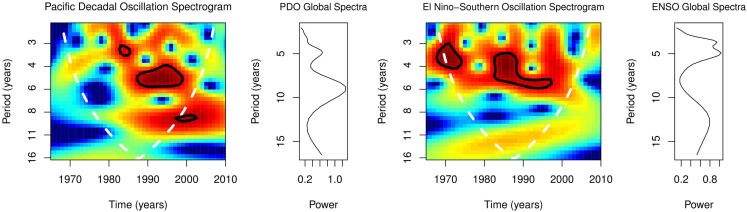
Spectral of PDO and ENSO.